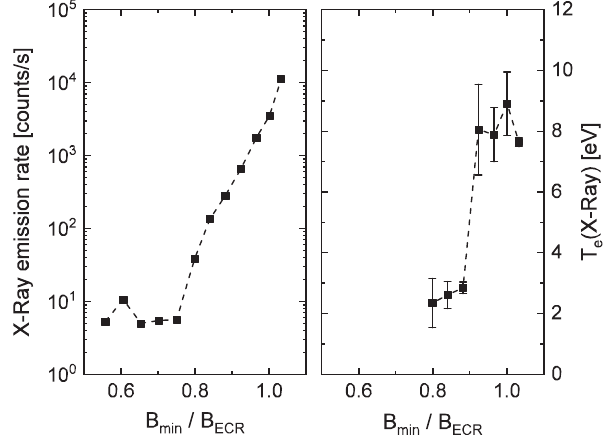
=B at FIG. 10. X-ray emission rate and electron temperature for the min ECR SDD detector versus B